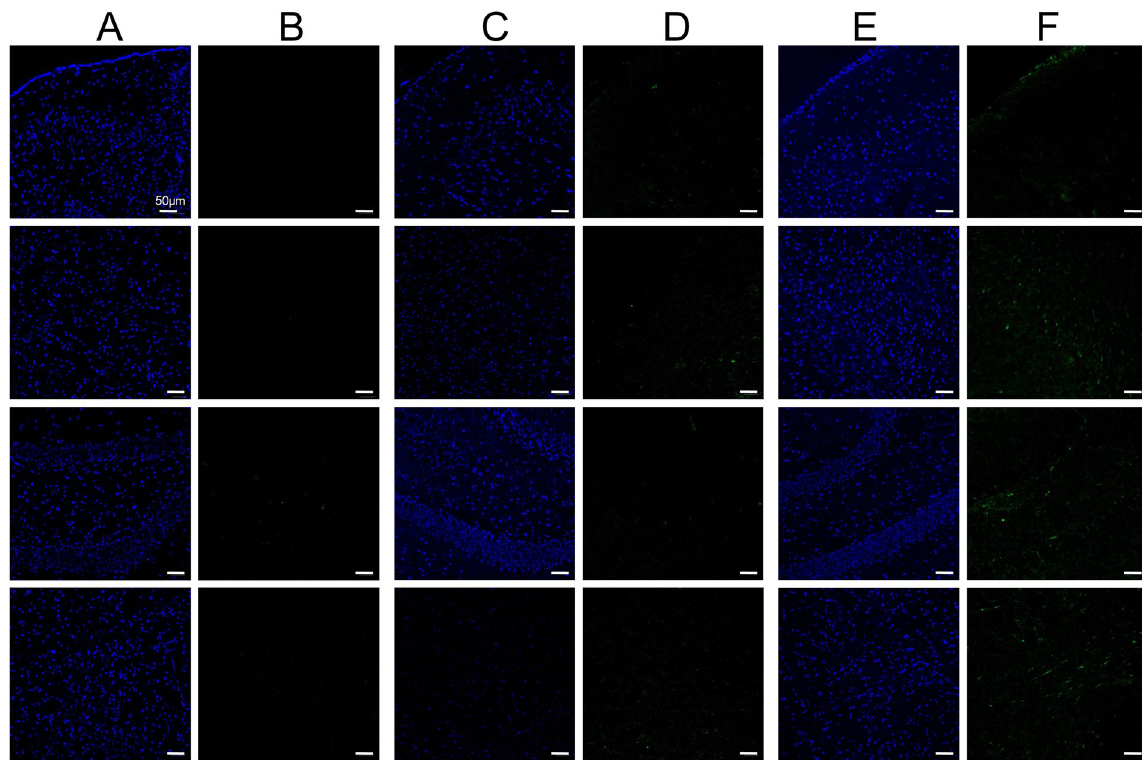
Figure 7. Confocal images of brain sections of rats treated with different formulations of Rho123. Free Rho 123 (columns A , B ), Rho123- incorporated F127 (columns C , D ) and FT mixed micelles (columns E , F ) were i.v. injected separately. Rows 1–4 were images of cortex, caudate, hippocampus, substantianigra respectively. Blue fluorescence: cell nuclei, green fluorescence: Rho123. Scale bar, 50 µ